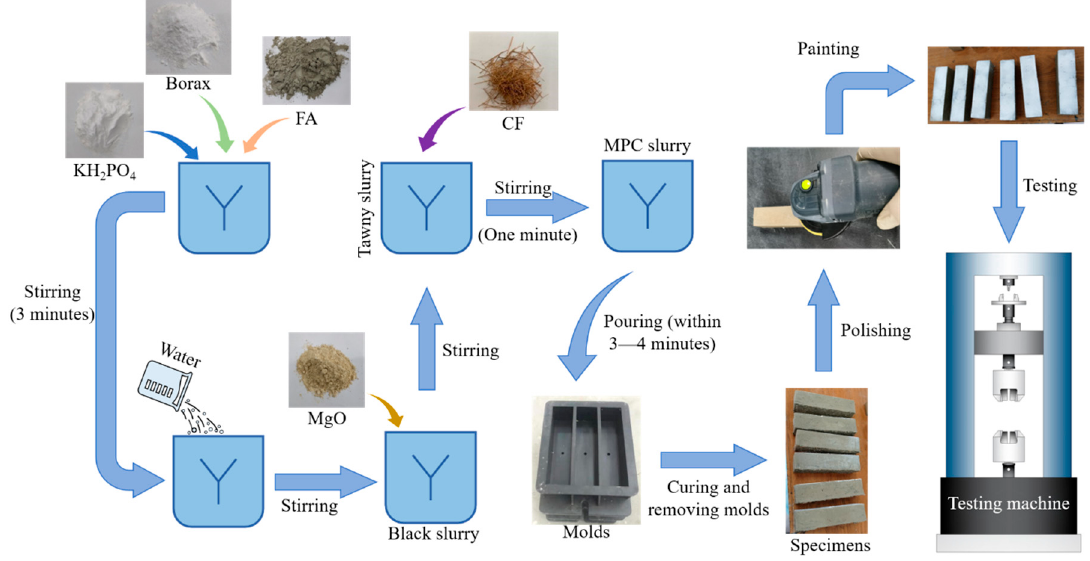
Figure 2. Preparation process of specimens.